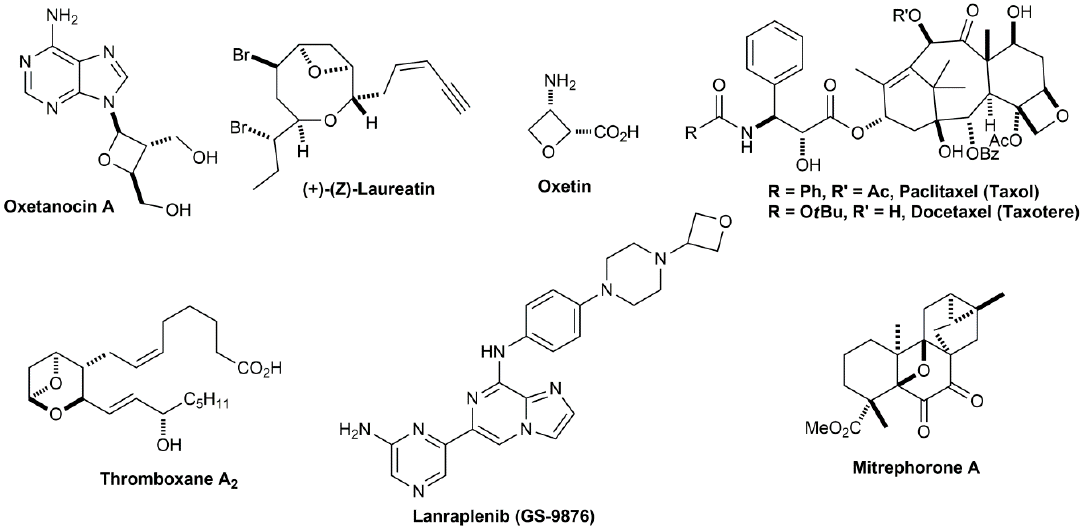
Figure 1. Natural products and marketed drugs containing an oxetane group.